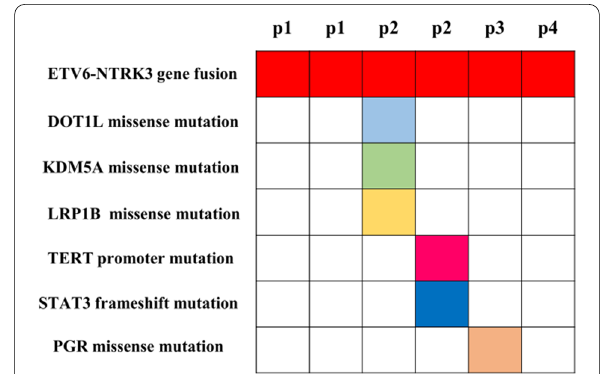
Fig. 4 Summary of next-generation sequencing results for 6 lesions in 4 secretory carcinoma patients. All lesions demonstrated ETV6– NTRK3 gene fusion by DNA sequencing. Patient 2 sequencing results showed DOT1L , KDM5A , LRP1B variants in primary lesions and TERT and STAT3 mutation variants in recurrent lesions, except for the same ETV6-NTRK3 gene fusion sites. Patient 3 had two ETV6-NTRK3 gene fusion sites, and PGR gene variation was